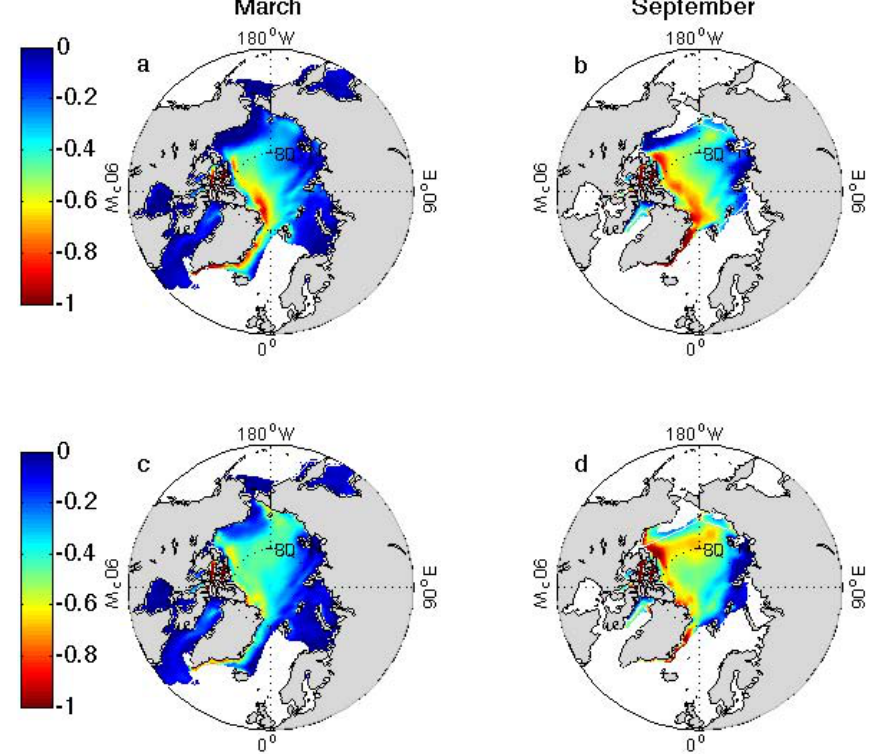
Fig. 13. March and September sea ice thickness change (in meters) due to light-absorbing particles (BC and dust) in snow and sea ice, for March using year 2000 deposition fluxes (a) , for September using year 2000 deposition fluxes (b) , for March using year 1850 deposition fluxes (c) , and for September using year 1850 deposition fluxes (d) . Sea ice extent plotted to the contour of 15% ice area for the aerosol deposition-free control case. Additionally in these and subsequent sea ice plots, the sea ice extent to the 15% contour for the case in question can be seen as a dashed white line if it differs sufficiently from the impurity-free ice